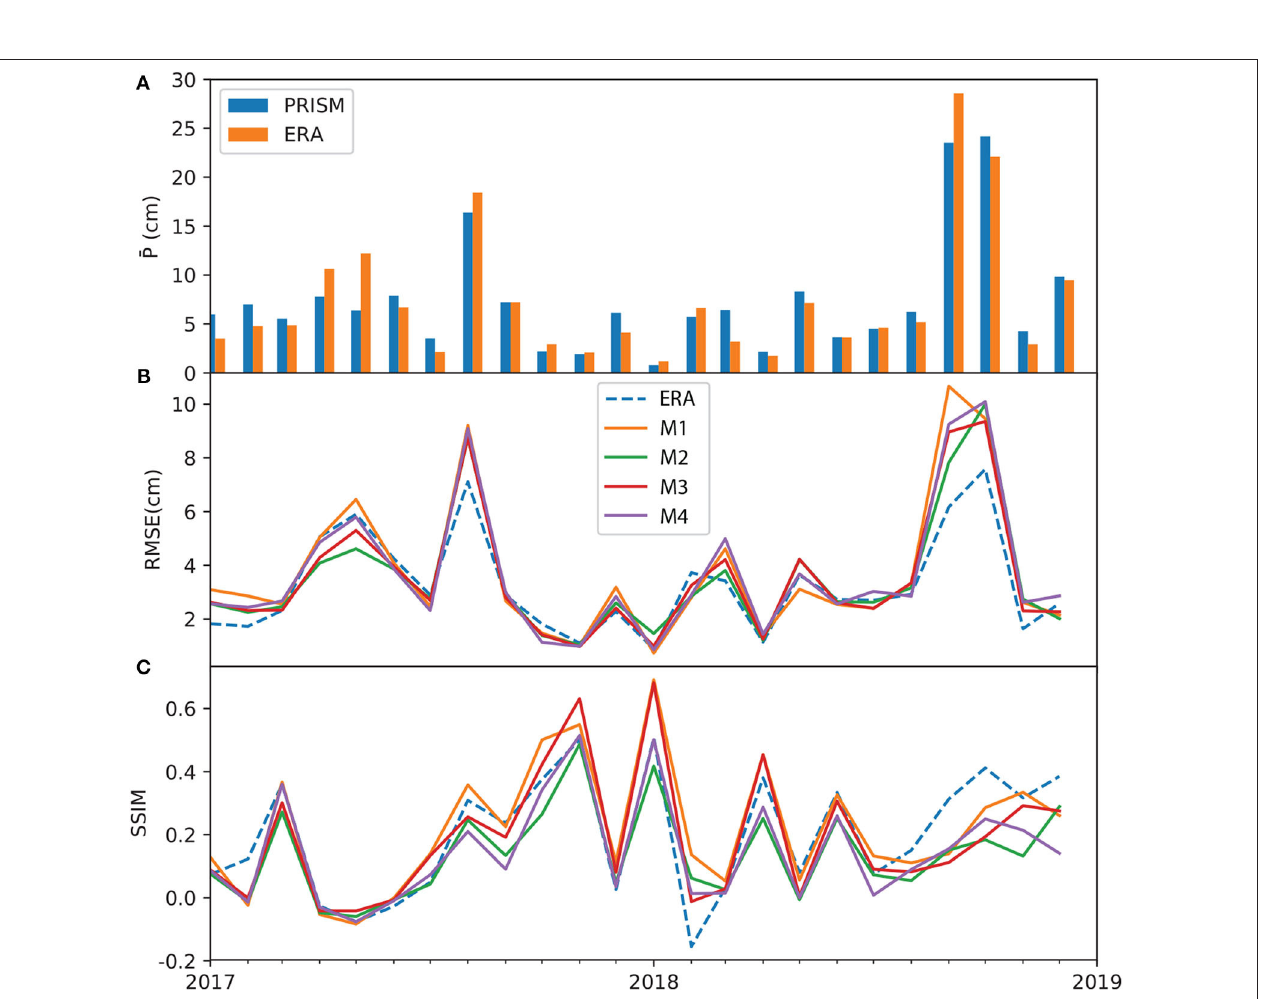
FIGURE 6 | Time series of ERA metrics over the test period (2017/01–2018/12): (A) monthly averaged PRISM and ERA data; (B) mean grid averaged RMSE; and (C) SSIM. All subplots share the same x axis.